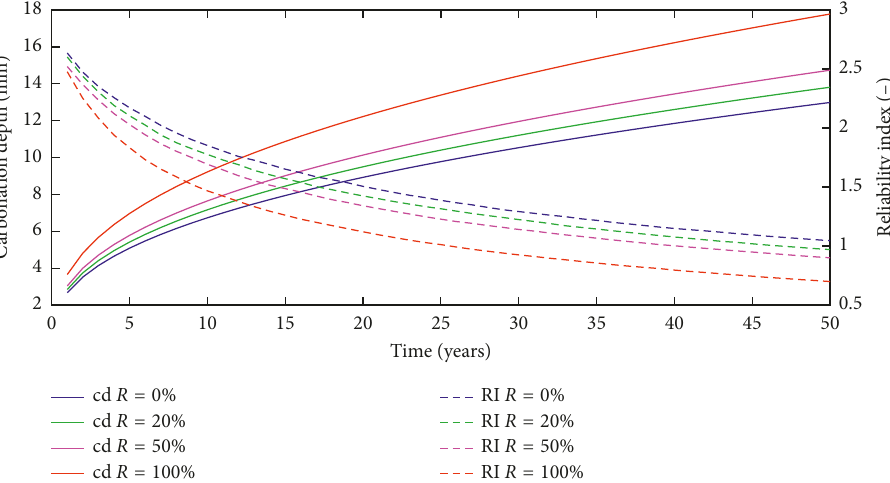
Figure 1: Carbonation depth (continuous line) and reliability index (dashed line) versus service life-XC1 exposure class: w/c � 0.65.